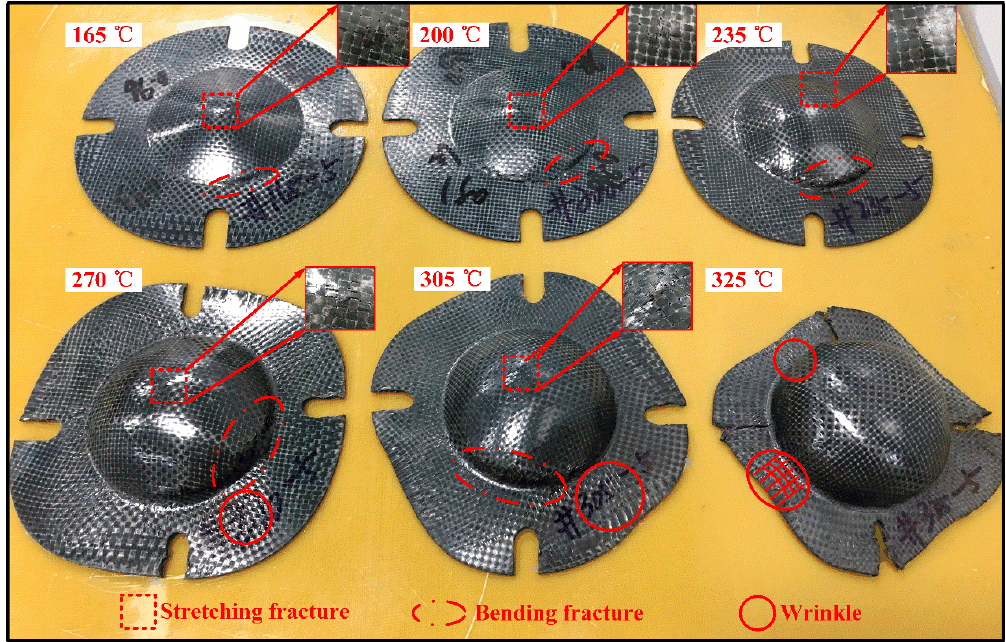
Figure 11. The fracture specimens of the Erichsen test of woven CF/PEEK sheets at different temperatures (5 mm/min).